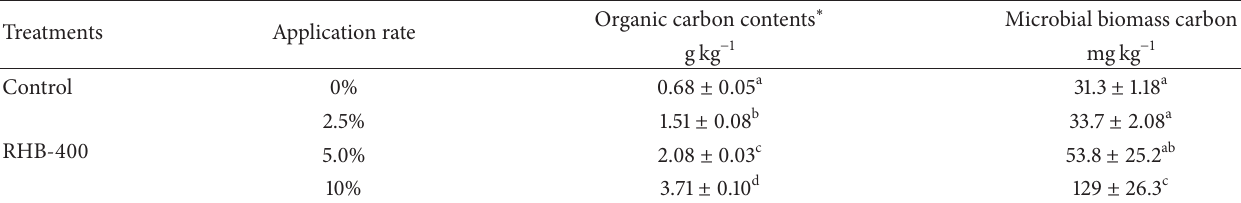
Table 4: Soil organic carbon contents and microbial biomass carbon of the studied soils after 168 d incubation.